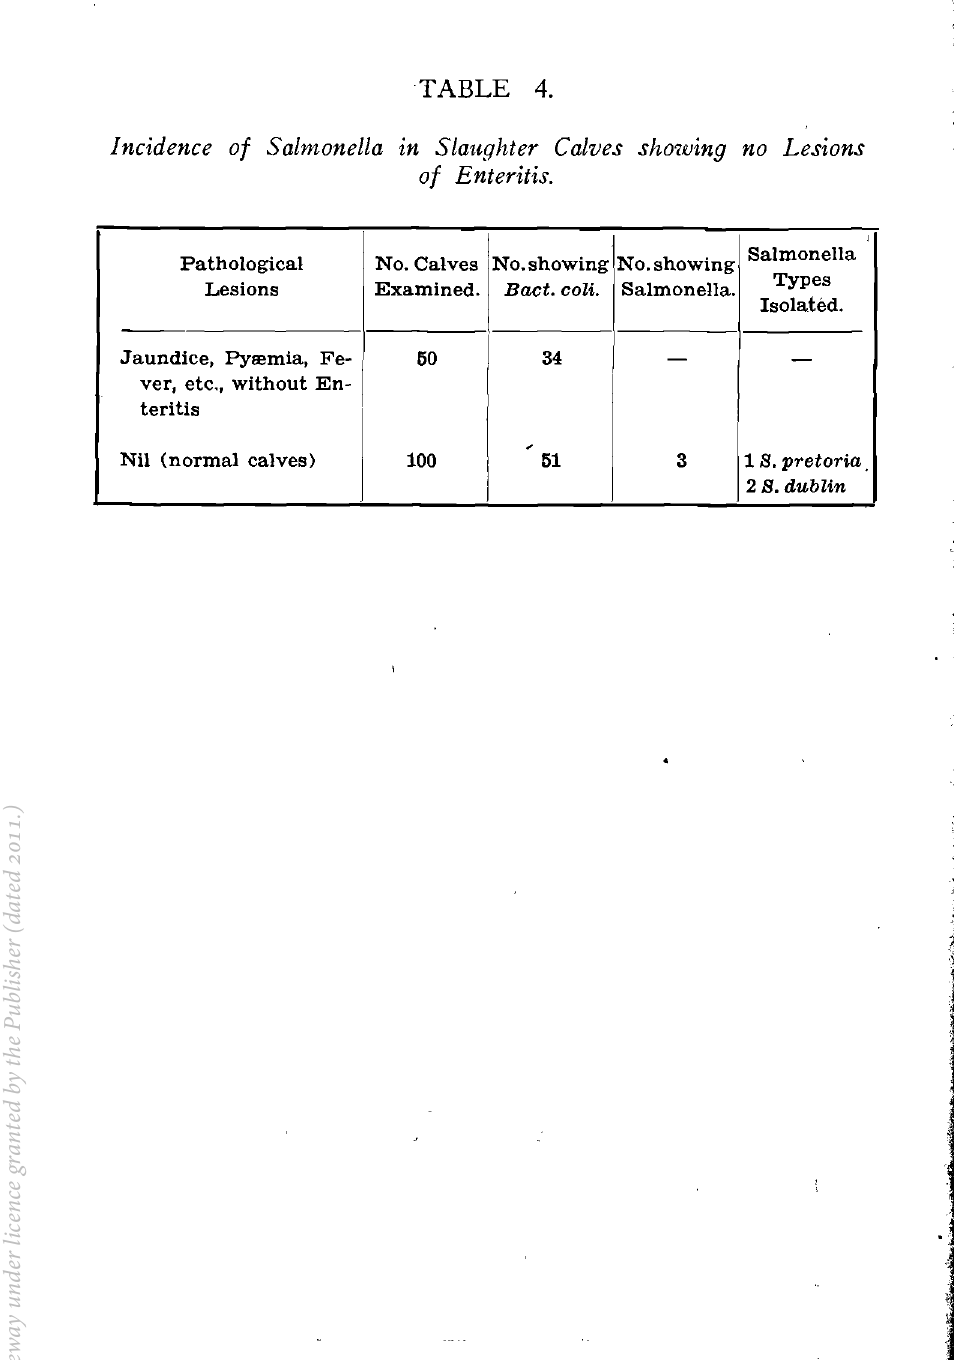
Incidence of Salmonella in Slaughter Calves showing no Lesions of